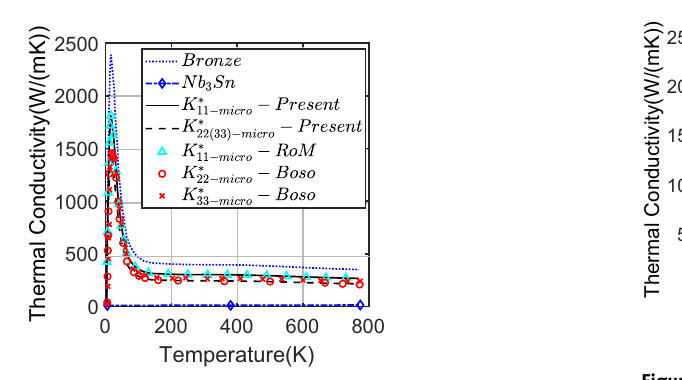
Figure 6: Comparison of homogenized thermal conductivity generated by LEHT and FEA [ 13 ] with v 0.24 f = for Nb 3 Sn fi laments at microscale.